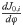
Drift and diffusion in ring-attractor models with short-term plasticity.A Excitatory (E) neurons (red circles) are distributed on a ring with coordinates in [−π, π]. Excitatory-to-excitatory (E-E) connections (red lines) are distance-dependent, symmetric, and subject to short-term plasticity (facilitation and depression, see Eq (3)). Inhibitory (I) neurons (blue circles) project to all E and I neurons (blue lines) and receive connection from all E neurons (gray lines). Only outgoing connections from shaded neurons are displayed. In simulations with integrate-and-fire neurons, each neuron also receives noisy excitatory spike input generated by independent homogeneous Poisson processes. B1 Example simulation: E neurons fire asynchronously and irregularly at low rates until (dotted line) a subgroup of E neurons is stimulated (external cue), causing them to spike at elevated rates (red dots, input was centered at 0, starting at t = 2s for 1s). During and after (dashed line) the stimulus, a bump state of elevated activity forms and sustains itself after the external cue is turned off. The spatial center of the population activity is estimated from the momentary firing rates (red line, plotted from t = 2.5s onward). Inset: Activity profile in the bump state, centered at 0. B2 Center positions of 20 repeated spiking simulations for 10 different initial cue positions each for a network with short-term depression (U = 1, τx = 150ms). Random E-E connections (with connection probability p = 0.5) lead to directed drift in addition to diffusion. Right: Normalized histogram (200 bins) of final positions at time t = 13.5. C Illustration of quantities used in theoretic calculations. Neurons in the bump fire at rates ϕ0,i (dashed black line, compare to B1, inset) due to the steady-state synaptic input J0,i (blue line). Movement of the bump center causes a change of the synaptic input dJ0,idφ (orange line). D Diffusion along the attractor manifold is calculated (see Eq (5)) as a weighted sum of the neuronal firing rates in the bump state (dashed black line). Spiking noise (red line) is illustrated as a random deviation from the mean rate with variance proportional to the rate. The symmetric weighting factors (blue lines show Ci2S2(dJ0,idφ)2 for varying U) are non-zero at the flanks of the firing rate profile. Stronger short-term depression and weaker facilitation increase the magnitude of weighting factors. E Deterministic drift is calculated as a weighted sum (see Eq (7)) of systematic deviations of firing rates from the bump state (frozen noise): a large positive firing rate deviation in the left flank (red line) will cause movement of the center position to the left (red arrow) because the weighting factors (blue lines show CiSdJ0,idφ for varying U) are asymmetric.